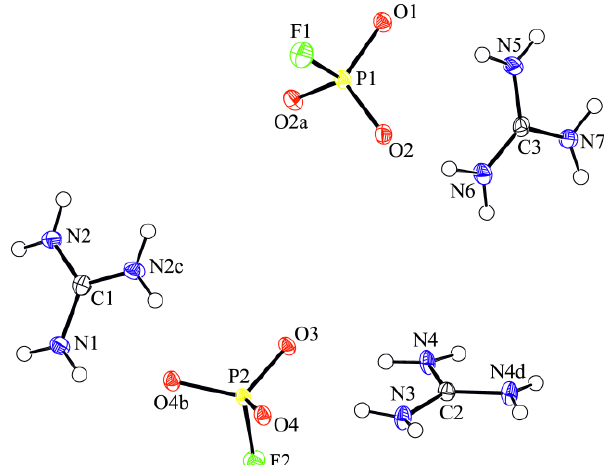
Figure 2. Atom numbering of bis(guanidinium) trioxofluorophosphate—compound (I). The anisotropic displacement parameters are shown at the 50% probability level. The symmetry codes for the atoms O2a and O4b: x , 2 − y , z ; for the atoms N2c and N4d: x , 1 − y , z . Applied colours: C—black, N—blue, O—red, H—black contour, P—yellow, F—green. The Figure was prepared by [17]. Table 2. Crystal data and details of data collection and refinement for compounds ( IV ) and ( V ).